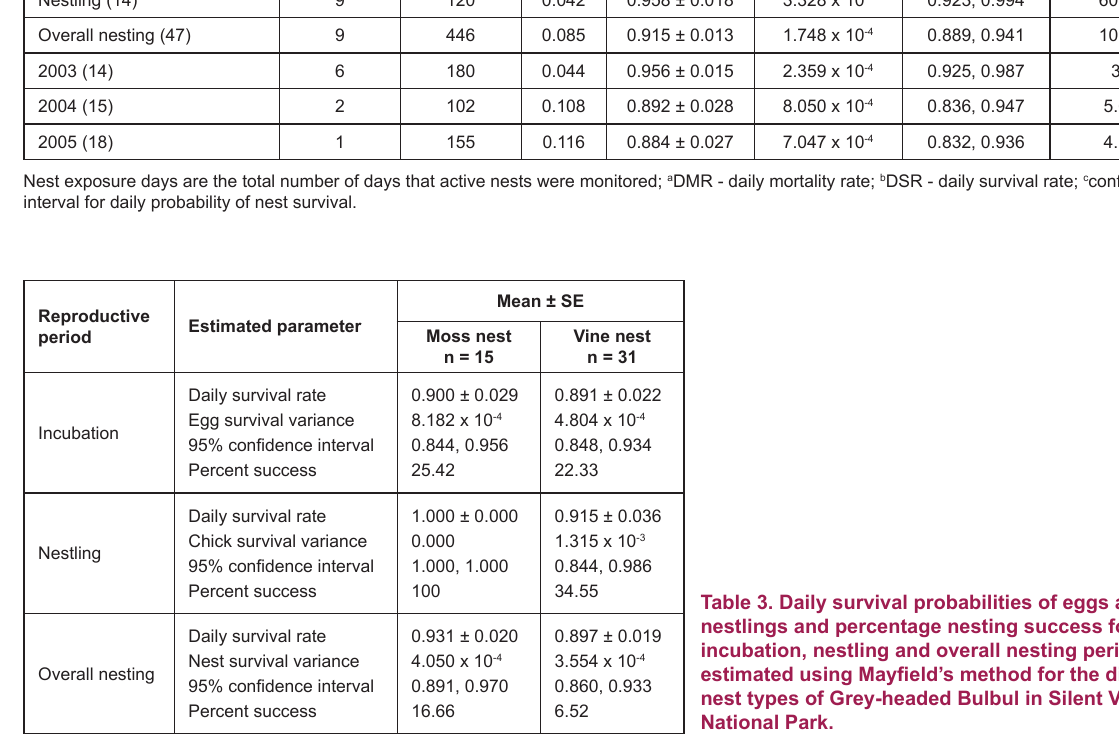
Table 2. Nest survival for Grey-headed Bulbul in different reproductive stages and breeding seasons. Reproductive period / Year (No. of nests monitored)